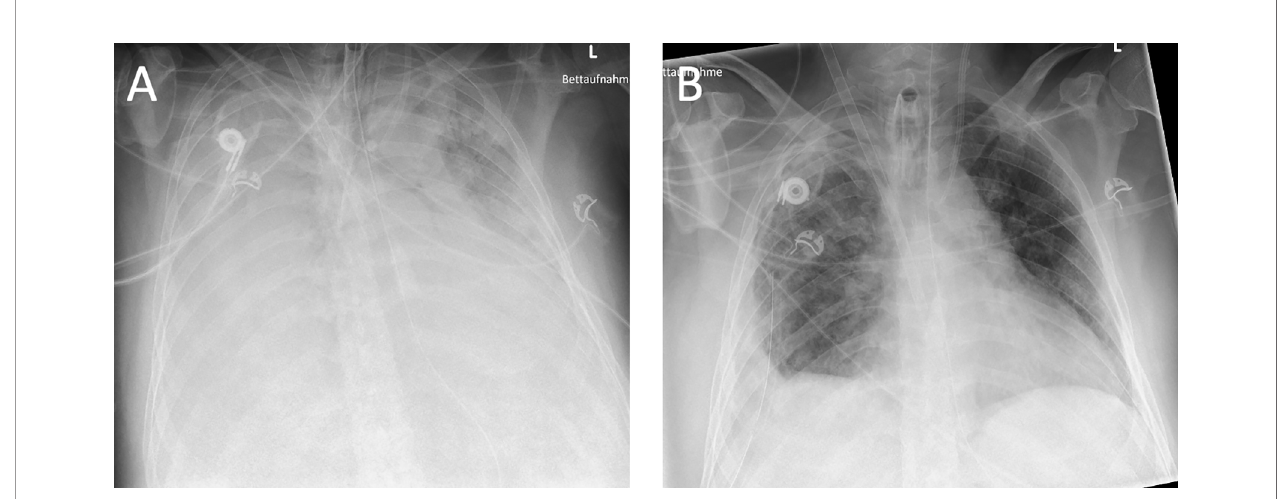
FIGURE 2 | Chest X-ray of the patient immediately before interferon administration at week 4 (A) and after administration and clinical improvement at week 6 (B)